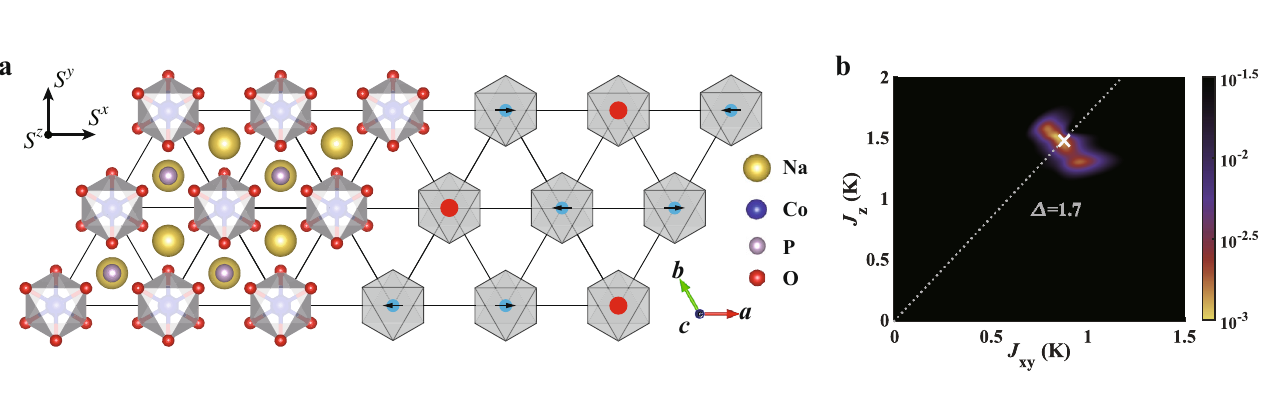
Fig. 1 Crystallographic structure of NBCP and fi tting loss landscape. a Top view of the crystallographic structure of the NBCP. Each Co 2 + ion carries an effective S = 1/2 spin owing to the octahedral crystal environment and the spin-orbital coupling. The spins form a triangular network. Its magnetic ground state is a spin supersolid: the red (blue) circles represent the positive (negative) S z component, and the black arrows show the direction of the S x , y component. The crystallographic a -, b -, and c -axes and the spin frame S x , y , z are shown in the bottom right and the top left insets, respectively. b Shows the projection of the fi tting loss function onto the J xy – J z plane (with J PD, Γ fi xed as zero), where brighter color represents less fi tting loss and therefore better fi t. The white cross marks the optimal parameter set, which corresponds to an S = 1/2 TLAF with anisotropy parameter Δ = J z / J xy ≃ 1.7 (dashed